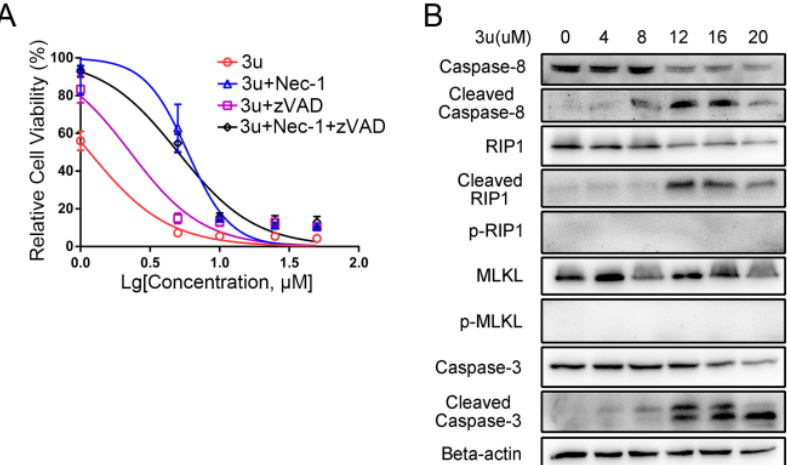
Figure 8. RIP1 kinase inhibitor Necrostatin-1 (Nec-1) inhibited necroptosis while apoptosis was not affected. ( A ) With or without pretreatment of 30 µM zVAD-fmk and/or 20 µM Nec-1 for 1 h, A375 cells were treated by different concentrations of 3u for 6 h, and cell growth was measured using MTT assay. ( B ) Apoptosis- and necroptosis-related proteins were examined using Western blot analysis after 20 µM Nec-1 pretreatment for 1 h and treatment with various concentrations of 3u for 6 h.